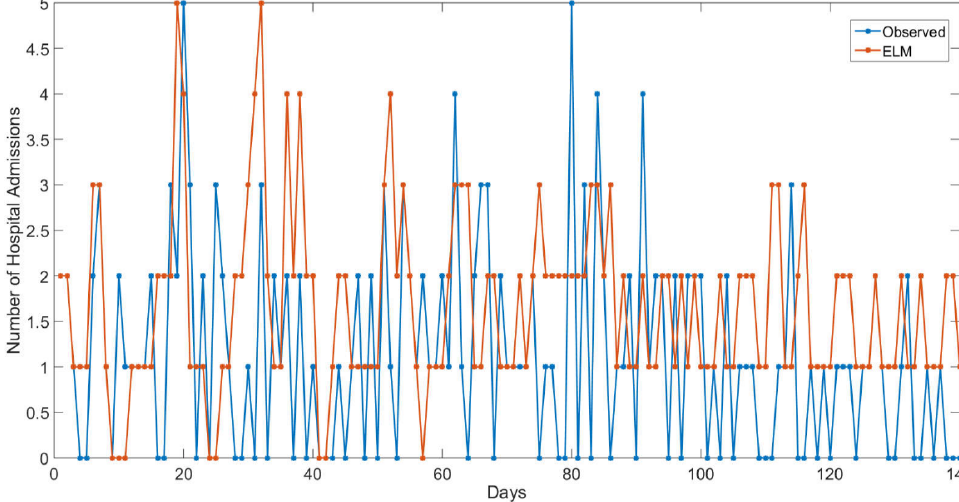
Figure 7. The number of hospital admissions by day of the test set for ELM lag 2-Cubatão (observed versus estimated